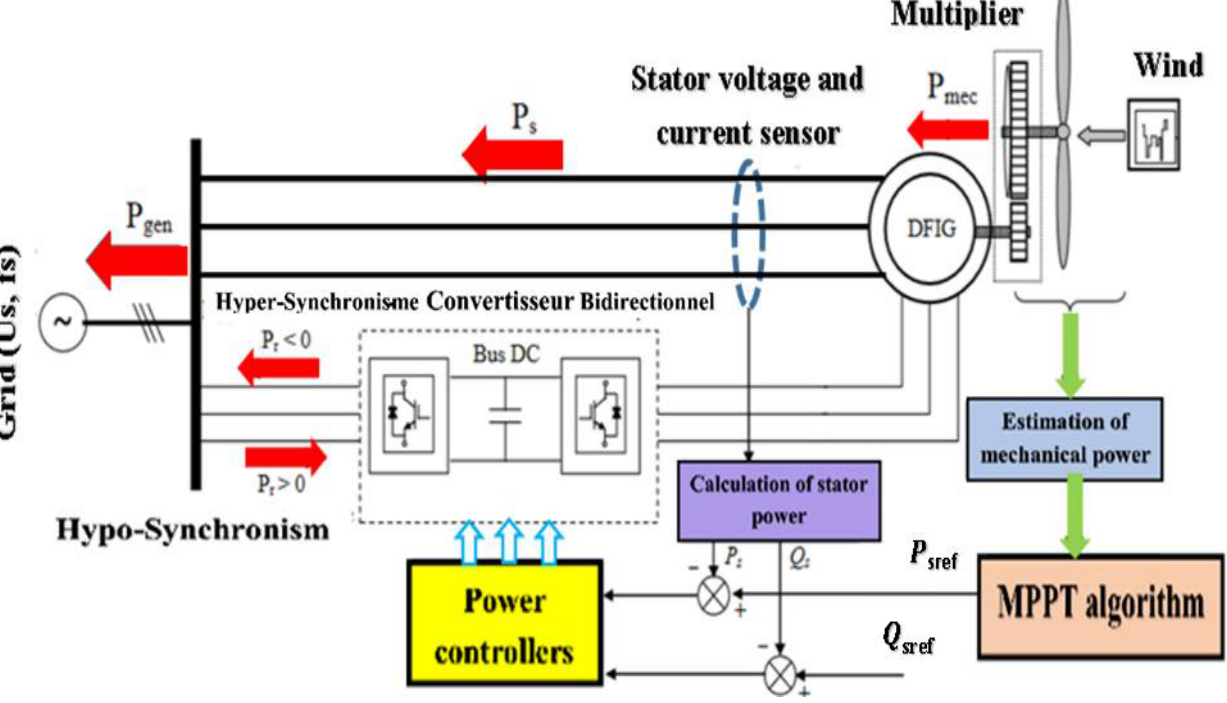
Figure 7. Configuration of a controlled wind power system connected to the grid.